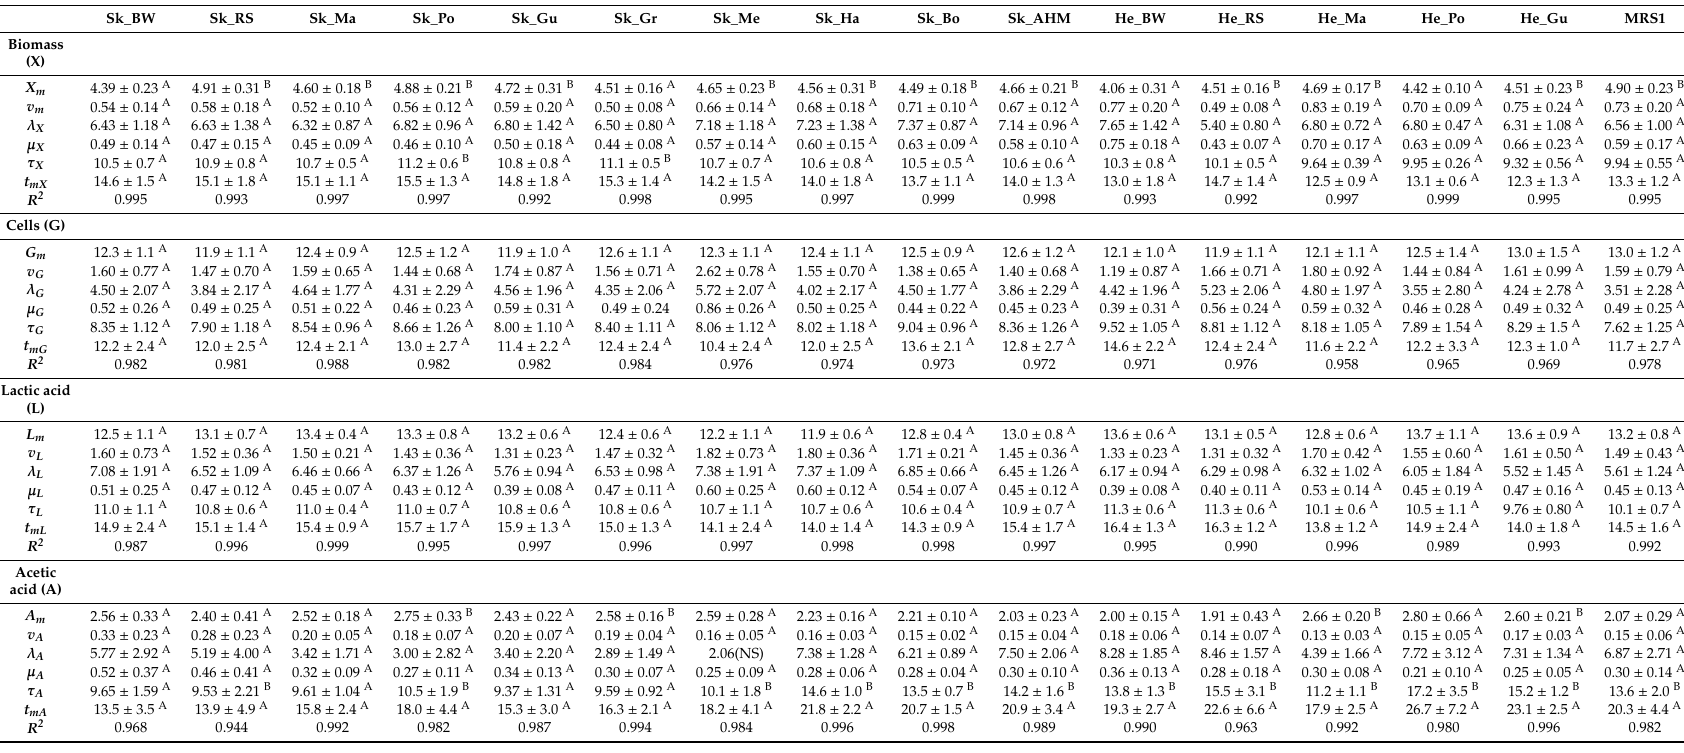
Table 2. Numerical values and confidence intervals for parameters obtained from experimental data of Lactobacillus brevis (Lb 1) modelled by Equations (1)–(4). R 2 is the determination coe ffi cient among experimental and predicted data. MRS1 and MRS2 are used as control commercial media in the two set of experiments. Di ff erent letters in each row (as superscript) mean significant di ff erence between fish peptone media and control media ( p <